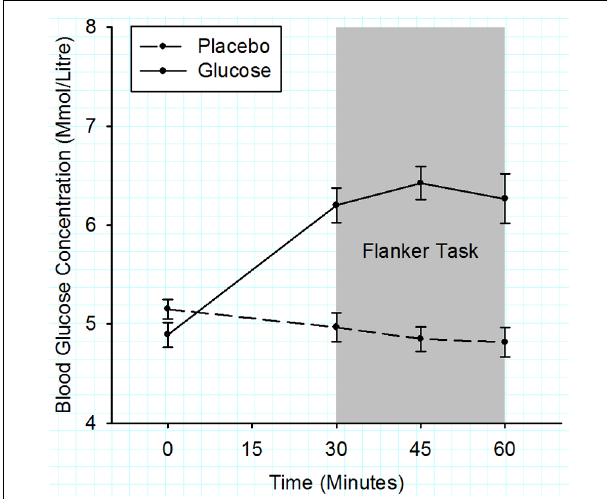
FIGURE 5 | Mean blood glucose concentrations measured in 15 min intervals for the duration of experiment 2. Solid lines represent the BGC in the glucose group and dashed lines the BGC in the placebo group.The gray shaded area indicates the time period when the flanker task was performed. Error bars represent the standard error of the